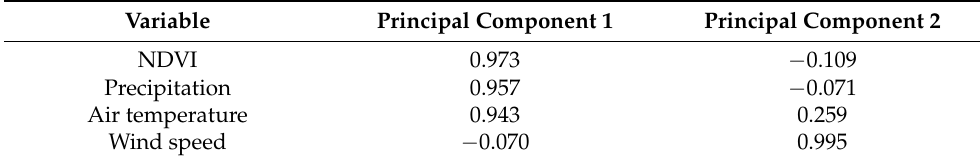
Table 6. Initial factor load matrix.